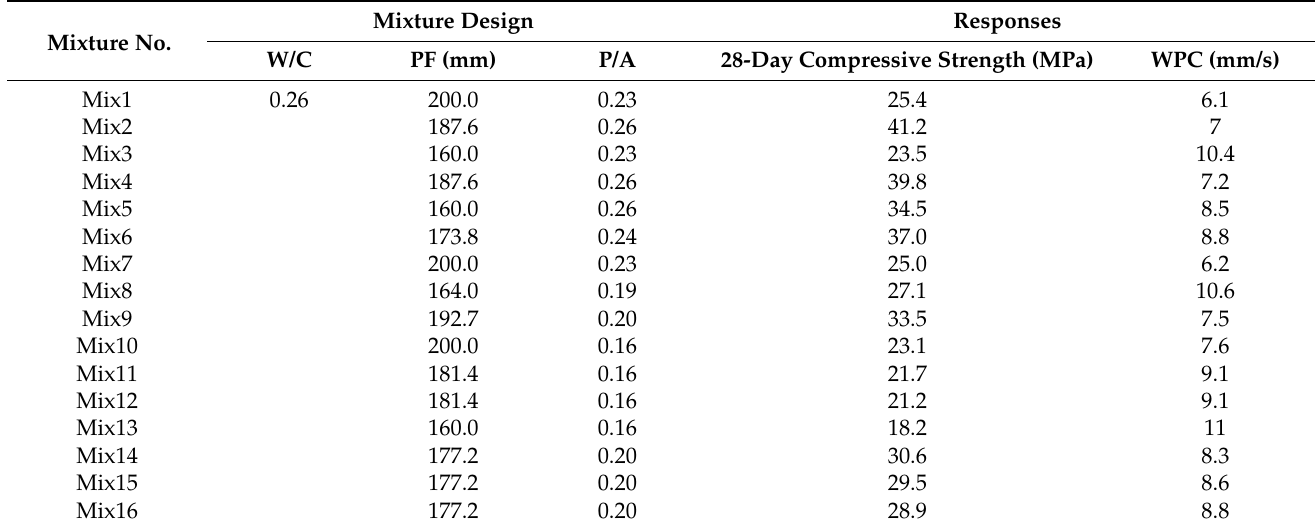
Table 4. Mixture design and experimental